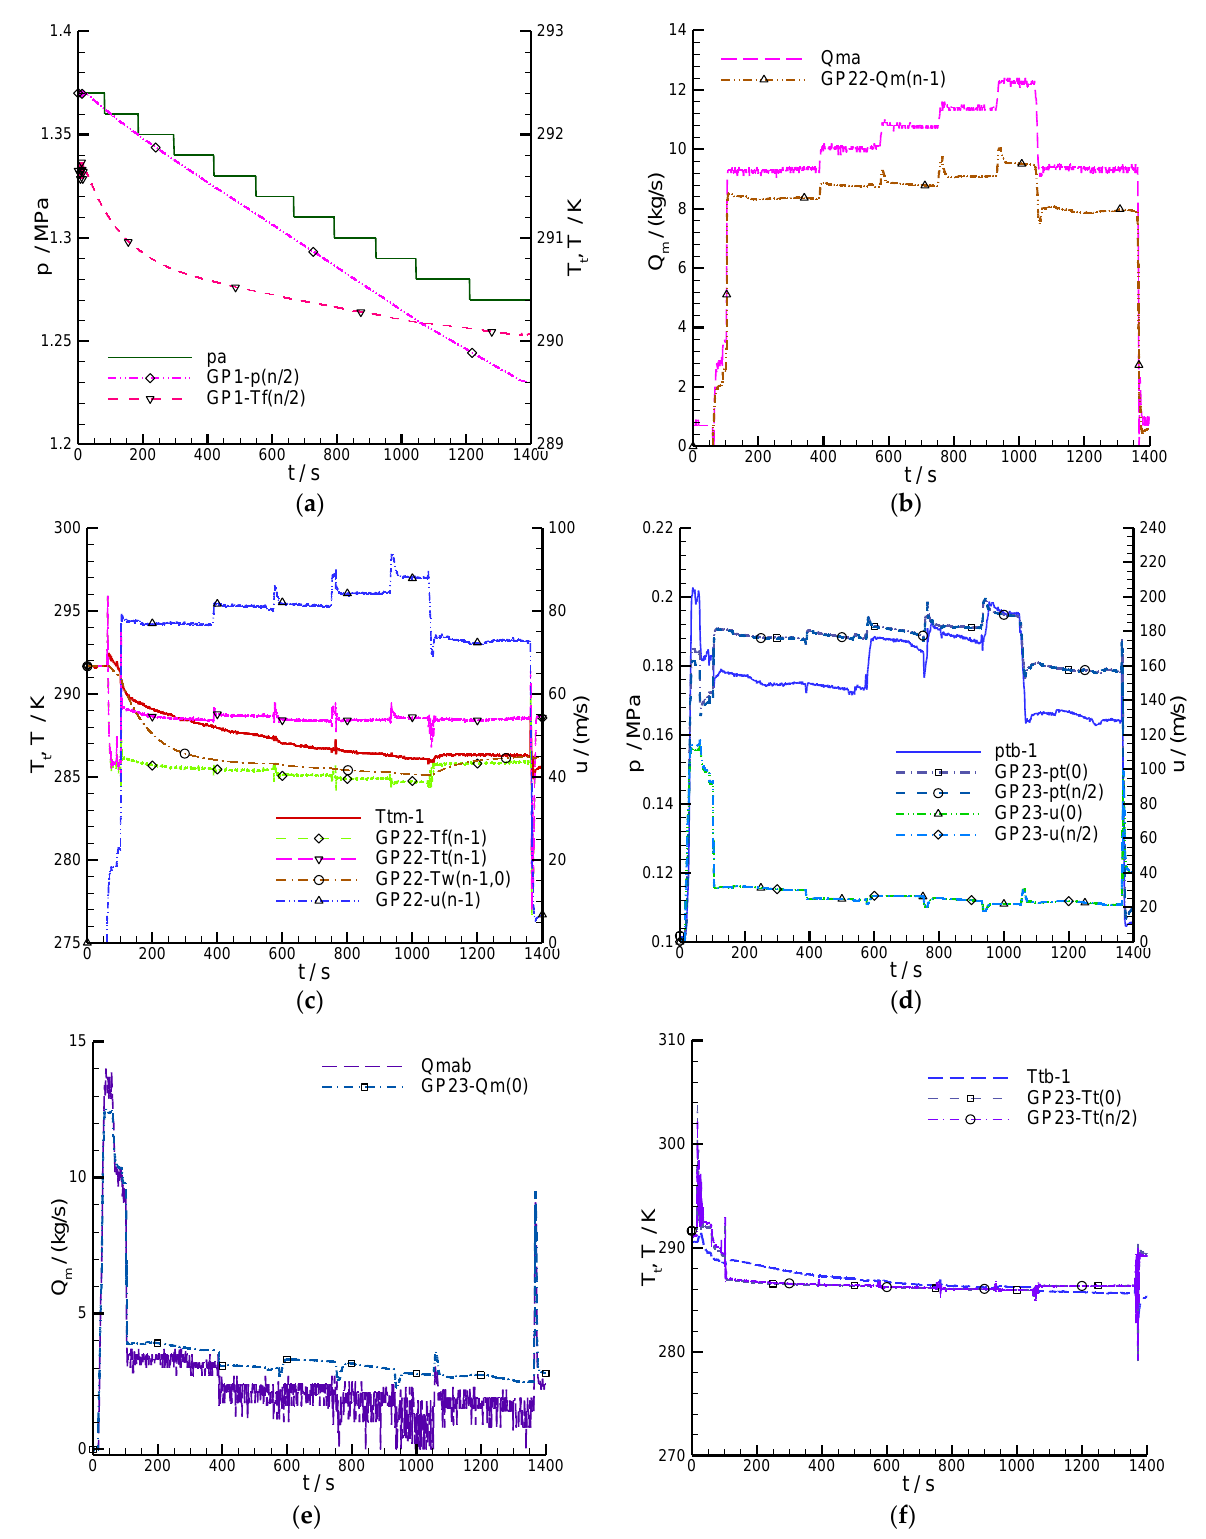
Figure 9. Comparison of simulation results with experimental measurements on the 1400 s normal-temperature condition. ( a ) Pressure of normal-temperature air at inflow measurement section. ( b ) Mass flow rate at engine inlet measurement section. ( c ) Total temperature at engine inlet measurement section. ( d ) Total pressure at bypass measurement section. ( e ) Mass flow rate at bypass measurement section. ( f ) Total temperature at bypass measurement section.